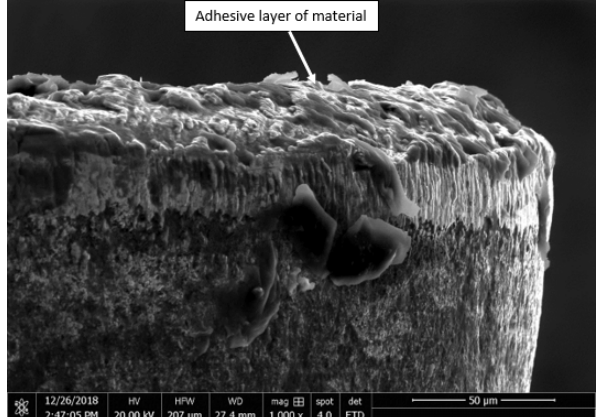
Figure 8. SEM image showing the adhesion of material on rake face at low speed ( V = 50mmin − 1